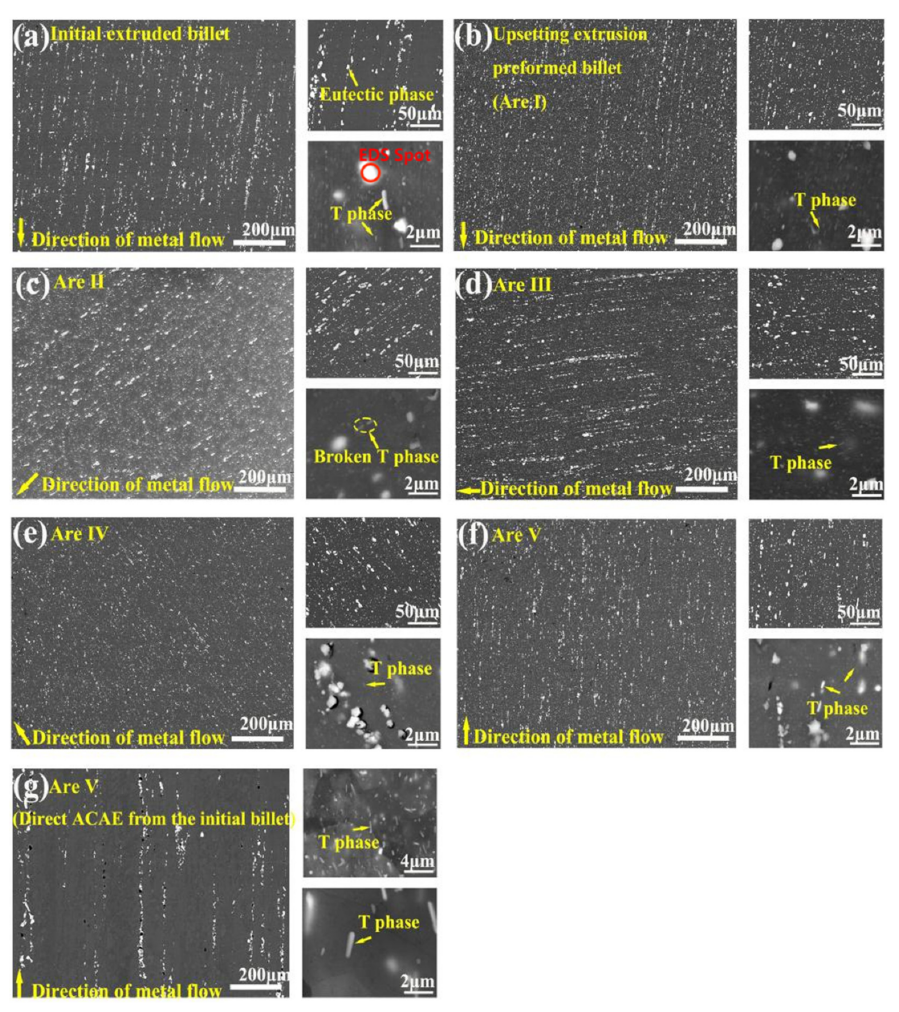
Figure 4. BSE image of the second-phase evolution during deformation: ( a ) initial billet; ( b ) billet deformed by UE; ( c ) UE + ACAE Zone II; ( d ) UE + ACAE Zone III; ( e ) UE + ACAE Zone IV; ( f ) UE + ACAE Zone V; and ( g ) ACAE Zone V.